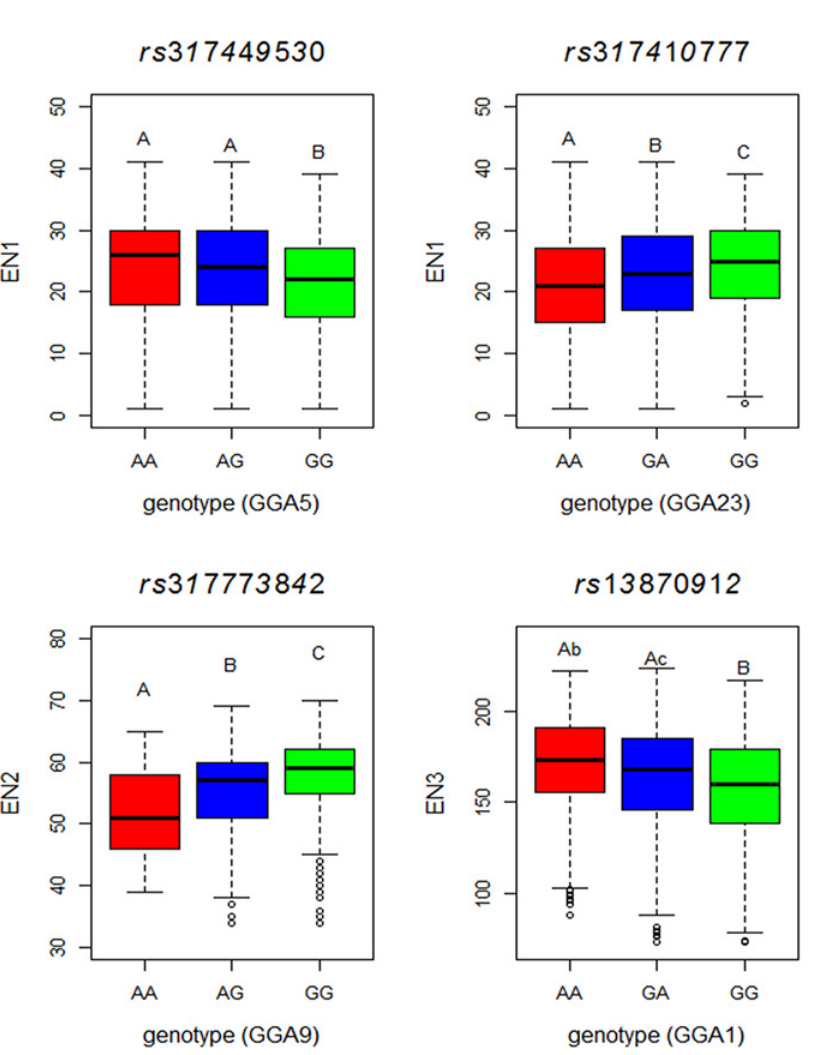
Fig 3. Box plot for effect of sentinel SNPs showing associations with egg number. EN1, egg numbers in pre-peak laying stage from 21 to 26 weeks of age. EN2, egg numbers in peak laying stage from 27 to 36 weeks of age. EN3, egg numbers in persistent laying stage from 37 to 72 weeks of